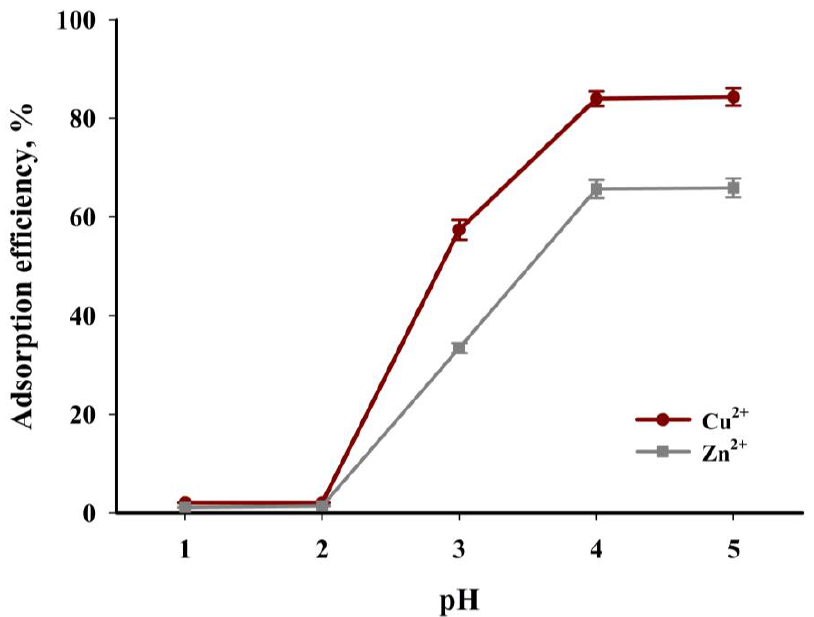
Figure 13. The influence of aqueous solution pH on adsorption efficiency ( T = 30 °C, t = 240 min, c = 200 mg·dm −3 , mass of adsorbent = 6.67 g·dm −3 ). c = 200 mg · dm − 3 , mass of adsorbent = 6.67 g · dm − 3 ).